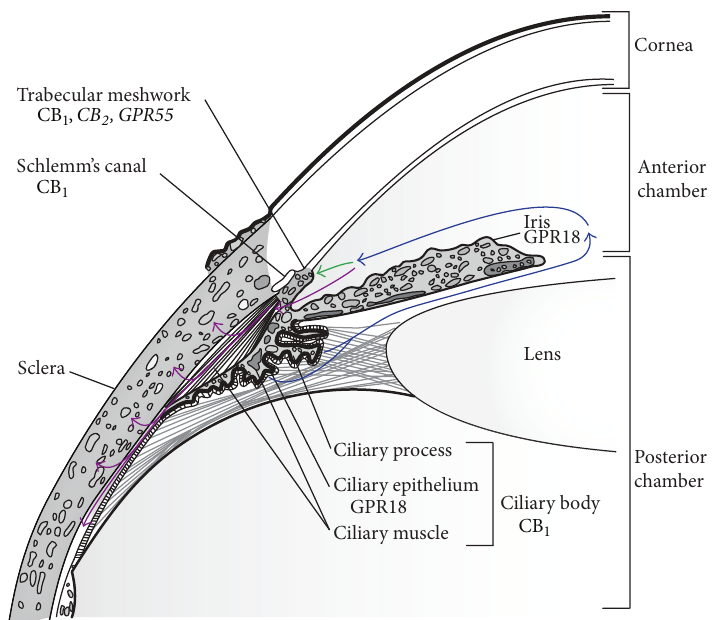
Figure 2: Cannabinoid-mediated alterations of the production and filtration of aqueous humor. Aqueous humor is formed by secretions from the ciliary body. Circulating aqueous humor (blue), flowing from the ciliary body in the posterior chamber to the anterior chamber, is filtered out of the eye through two different outflow pathways: the trabecular meshwork pathway (green) and the uveoscleral pathway (purple). The trabecular meshwork pathway involves the flow of aqueous humor through the trabecular meshwork to Schlemm’s canal, where it will exit throughtheepiscleralveins.Theuveoscleralpathwayinvolvestheflowofaqueoushumorfromtheiridocornealangletotheposteriorchamber through the ciliary body, and out through the supraciliary and suprachoroidal spaces. CB 1 , the major contributor to the IOP lowering effects of Δ 9 -THC and WIN 55,212-2, has been localized to the ciliary body, trabecular meshwork, and Schlemm’s canal [11, 13–15, 17]. The IOP lowering effects of NAGly and Abn-CBD, and possibly CBG-DMH, are due to the activation of GPR18, which has been localized to the ciliary epithelium and iris [26, 58]. Additional pharmacological evidence has suggested that CB 2 and GPR55 are localized within the trabecular meshwork [23, 28]; the contribution of these receptors to changes in IOP is unknown. COX-2 derived prostaglandins and prostamides are purported to exert actions through the uveoscleral pathway; however, the exact mechanism(s) is unclear [36, 62, 63]. Figure adapted from Riordan-Eva [94]. Italics indicate potential receptor localization which is not yet